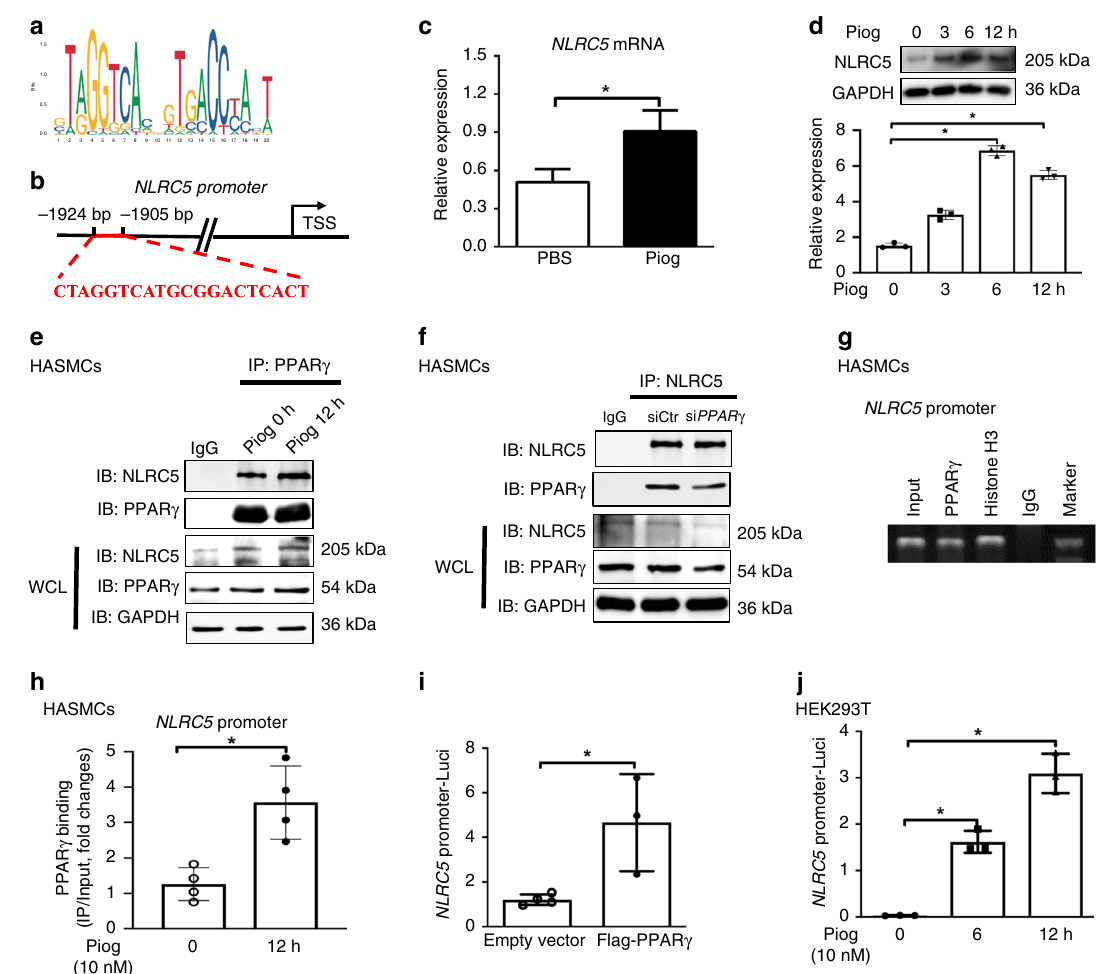
Fig. 5 PPAR γ binds to NLRC5 promoter and facilitate NLRC5 transcription. a The base sequence represents the consensus PPAR γ -binding motif (JASPAR). b The sequence at NLRC5 promoter indicates the putative PPAR γ -binding element. c The mRNA expression levels of NLRC5 in HASMCs in response to pioglitazone (10 nM) for 12 h are determined by quantitative RT-PCR. d Representative western blotting of NLRC5 and GAPDH in HASMCs treated with Pioglitazone (10 nM) for 0, 3, 6, and 12 h. e Co-immunopricipitation of NLRC5 and PPAR γ in HASMCs with and without pioglitazone (10 nM) treatment. The lysates immunoprecipitated with anti-IgG serve as negative control. f Co-immunopricipitation of NLRC5 and PPAR γ in HASMCs transfected with siCtr or si PPAR γ . The lysates immunoprecipitated with anti-IgG serve as negative control. g Chromatin immunoprecipitation (ChIP) assay is performed to evaluate the binding of PPAR γ to NLRC5 promoter in HASMCs without PDGF-BB treatment. ChIP is performed with anti-PPAR γ antibody, anti-histone H3, and normal rabbit IgG. The input represents electrophoresis of chromatin fragments without immunoprecipitation. h ChIP-qPCR is performed on HASMCs with antibodies to PPAR γ and the target promoter region of NLRC5 is ampli fi ed by qPCR. Data are presented as relative enrichment over input ± SD of three biological repeats. i HEK293T cells are co-transfected with empty or Flag-tagged PPAR γ plasmid and pGL3- NLRC5 -promoter-Luci plasmid for 24 h. Then the activity of NLRC5 promoter is measured by Dual Luciferase Reporter system. j HEK293T cells are transfected with pGL3- NLRC5 -promoter-Luci plasmid for 24 h and then treated with Pioglitazone (10 nM) for 6 and 12 h. Two-tailed Student ’ s t -test is used to compare two groups ( c , h , and i ), and analysis of variance (ANOVA) followed by Bonferroni post hoc analysis was used to compare three or more groups ( d and j ). Data are presented as mean ± SD from three independent experiments. * P < 0.05. Source data are provided as a Source Data fi